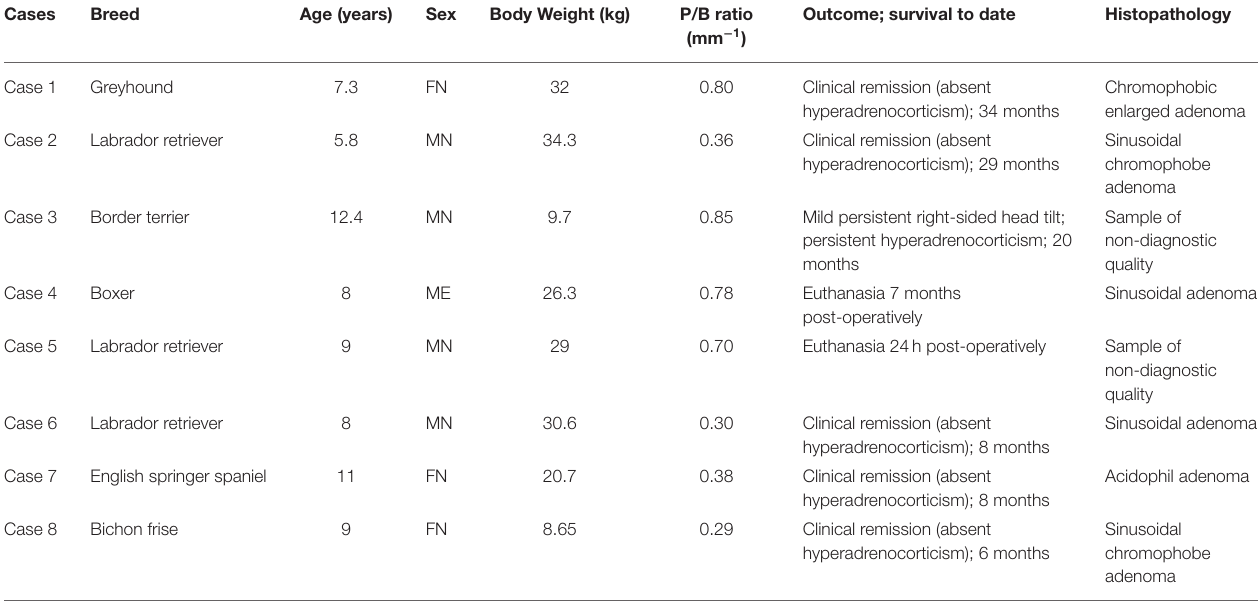
TABLE 1 | Signalment, pituitary height/brain area ratio (P/B ratio), and clinical outcome in the eight dogs in which transsphenoidal hypophysectomy was performed with the use of the 3D-patient-specific surgical guide.